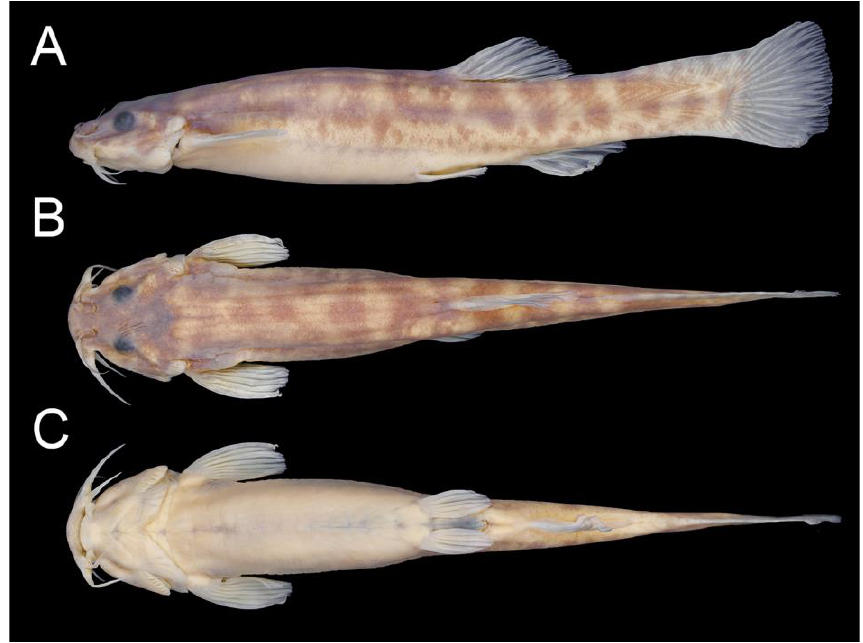
Figure 16. Trichomycterus macrophthalmus , UFRJ 5683, paratype, 56.2 mm SL: ( A ) lateral, ( B ) dorsal, and ( C ) ventral views.